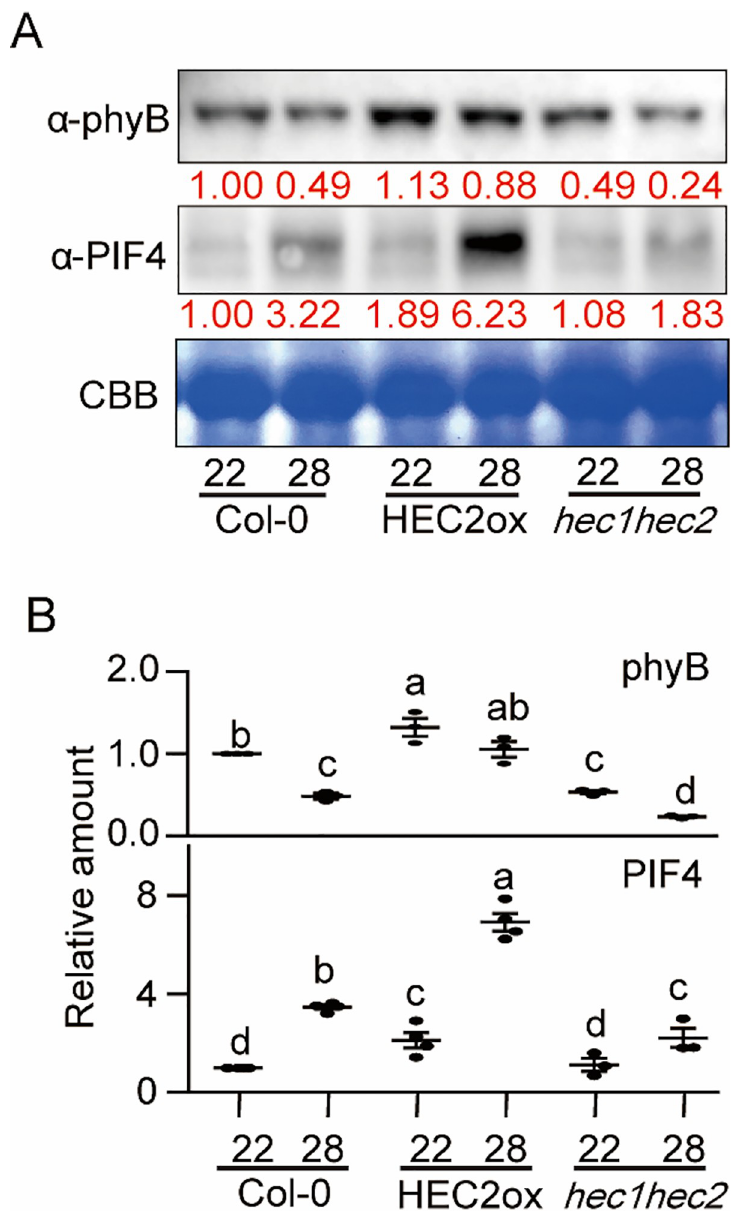
Fig 4. HECs alter phyB-PIF4 level at high ambient temperature. (A) Western blot shows the level of phyB or PIF4 in WT, 35S : HEC2-GFP and hec1hec2 mutant. Whole seedlings were grown for 5 days at 22˚C and either kept at 22˚C or transferred to 28˚C for 4 hours. Coomassie staining was used as a loading control. Red number indicates the quantitation value from anti-phyB or anti-PIF4 levels divided by Coomassie blue staining intensity. (B) Dot plot shows the relative amount of phyB (n = 3) or PIF4 (n = 3 or 4). Asterisks indicate statistically significant differences using Student’s t-test; �� p <